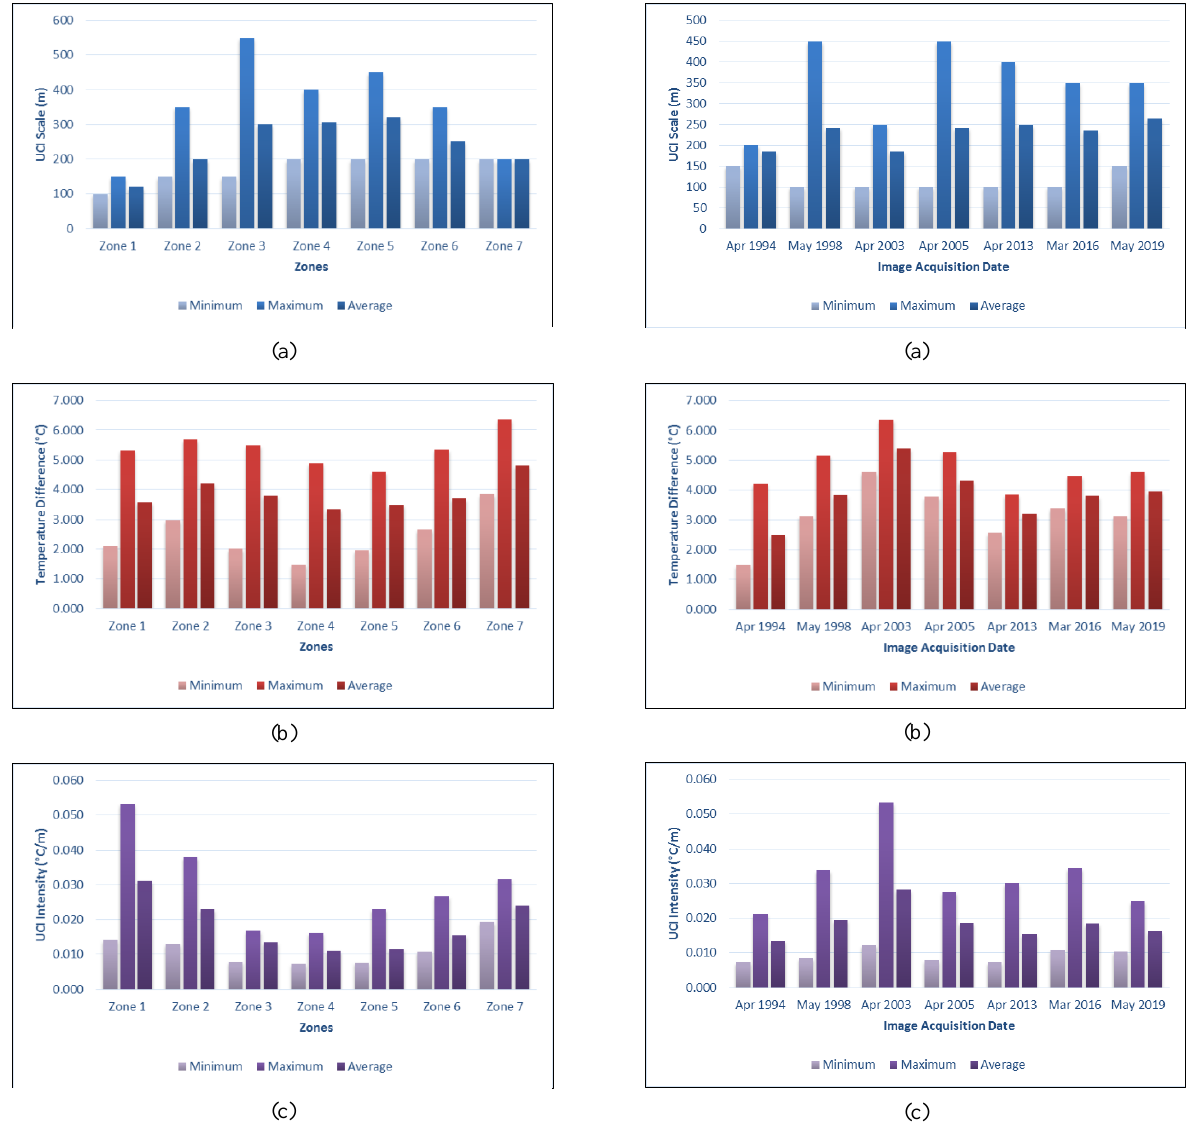
Figure 8. Minimum, maximum, and average (a) scale, Figure 9. Minimum, maximum, and average (a) scale, (b) temperature difference, and (c) intensity per image